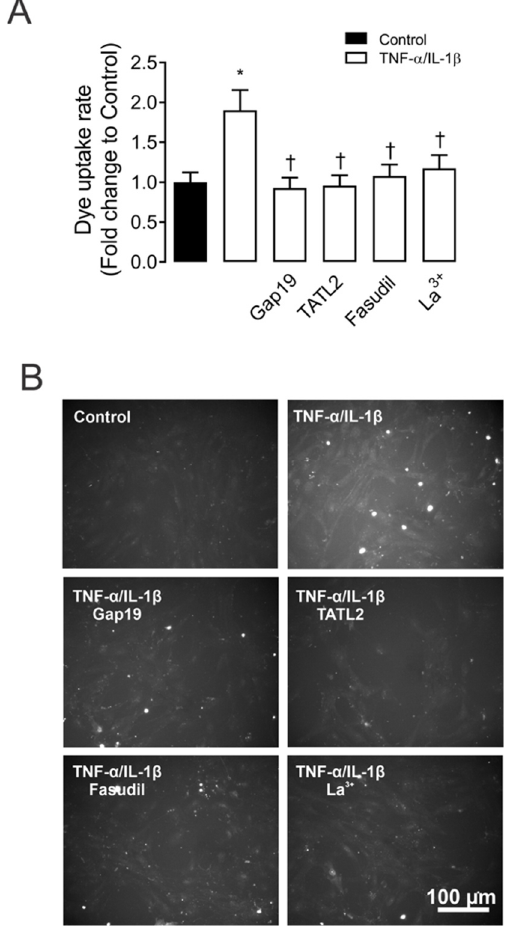
Figure 1. ROCK and Cx43 HC blockers reduce the TNF- α /IL-1 β -induced Etd + uptake in mesangial cells. ( A ) Etd + uptake rate in primary MCs under control conditions (Ctrl, black bar), exposed to TNF- α /IL-1 β (10 ng/mL each, white bars) for 72 h alone or with ROCK inhibitor: Fasudil (15 µM); and HCs blockers: Lanthanum ion (La 3+ , 200 µM) and selective Cx43 HC blockers: mimetic peptides Gap19 (100 µM) and TAT-L2 (100 µM). ( B ) Fluorescence images show primary MCs exposed to ethidium (5 µM Etd + ) for 13 min under TNF- α /IL-1 β stimulation with or without different blockers. Scale bar = 50 µm. Each bar represents the mean value ± SEM of five independent experiments with four replicates each. Statistical significance * p < 0.05 vs. Ctrl; † p < 0.05 vs. TNF- α /IL-1 β . Fasudil was added during the last 24 h of treatment. Gap19, TAT-L2 and La 3+ were added acutely (added 15 min before each Etd + uptake recording).